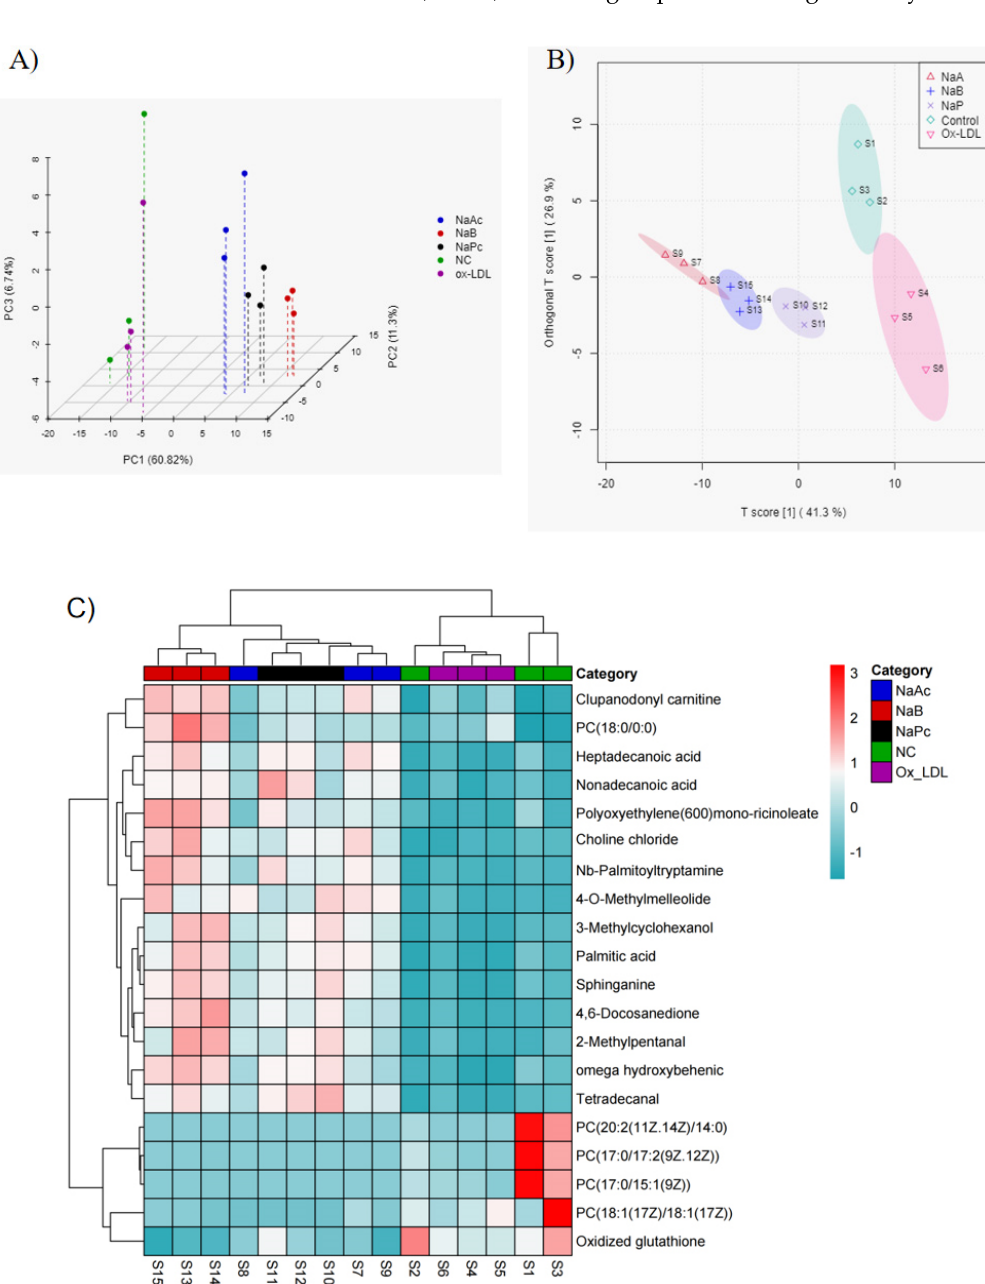
Figure 5. The PCA score plots, OPLS-DA score plots, and heat map of differential metabolites in THP-1 cells after being treated with the three main SCFAs. ( A ) PCA score plots; ( B ) OPLS-DA score plots; ( C ) heat map.